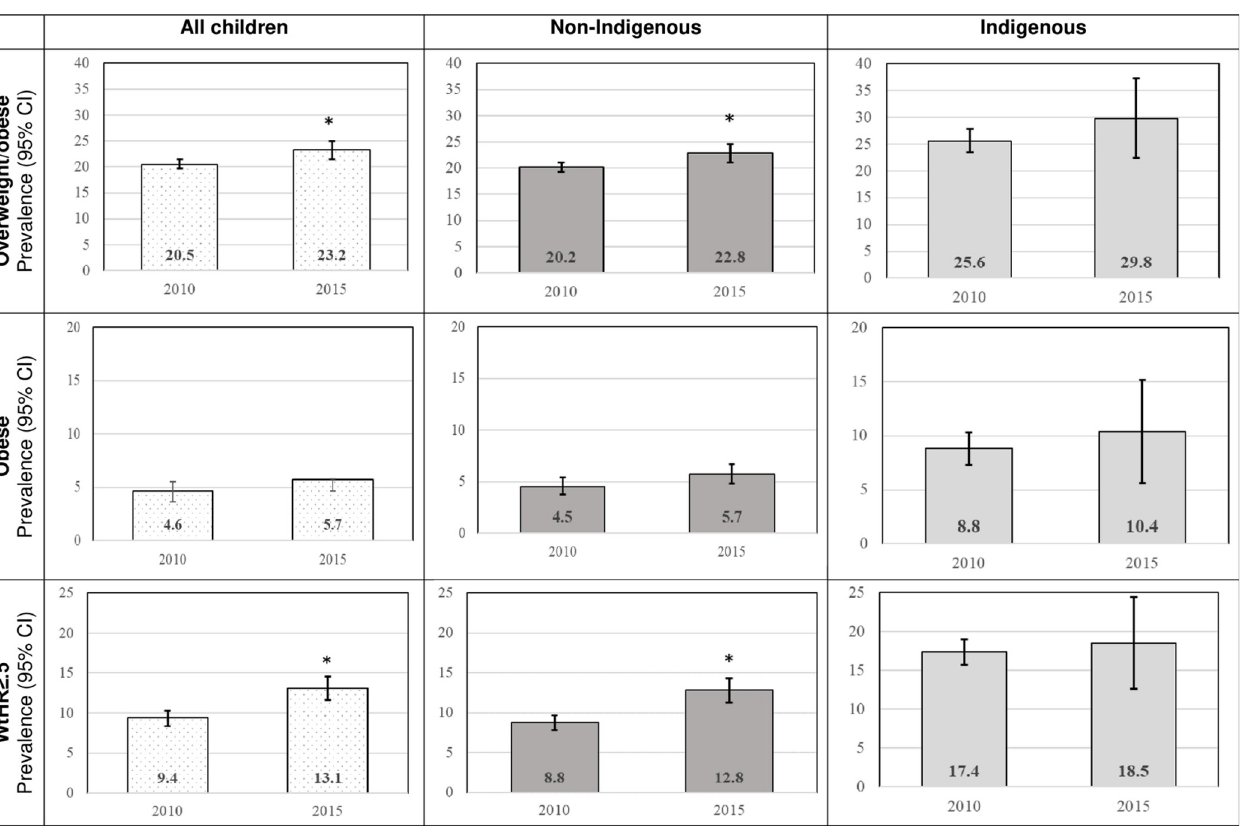
Fig 1. Adjusted prevalence (%, 95%CI) of children’s weight status in 2010 and